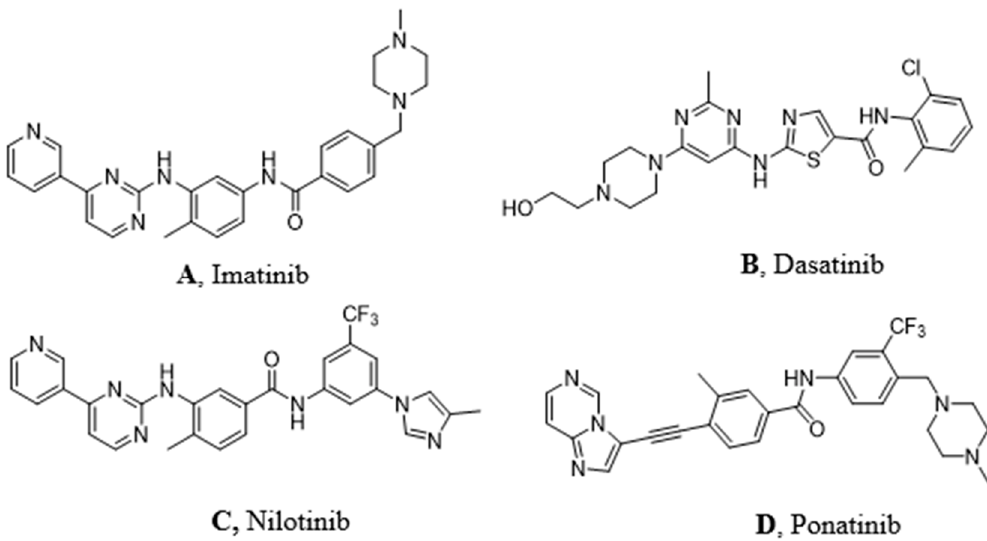
Figure 2. Molecular structures of the principal BCR-ABL TKIs used for treating pediatric chronic myeloid leukemia (CML): ( A ) Imatinib; ( B ) Dasatinib; ( C ) Nilotinib; ( D ) Ponatinib.